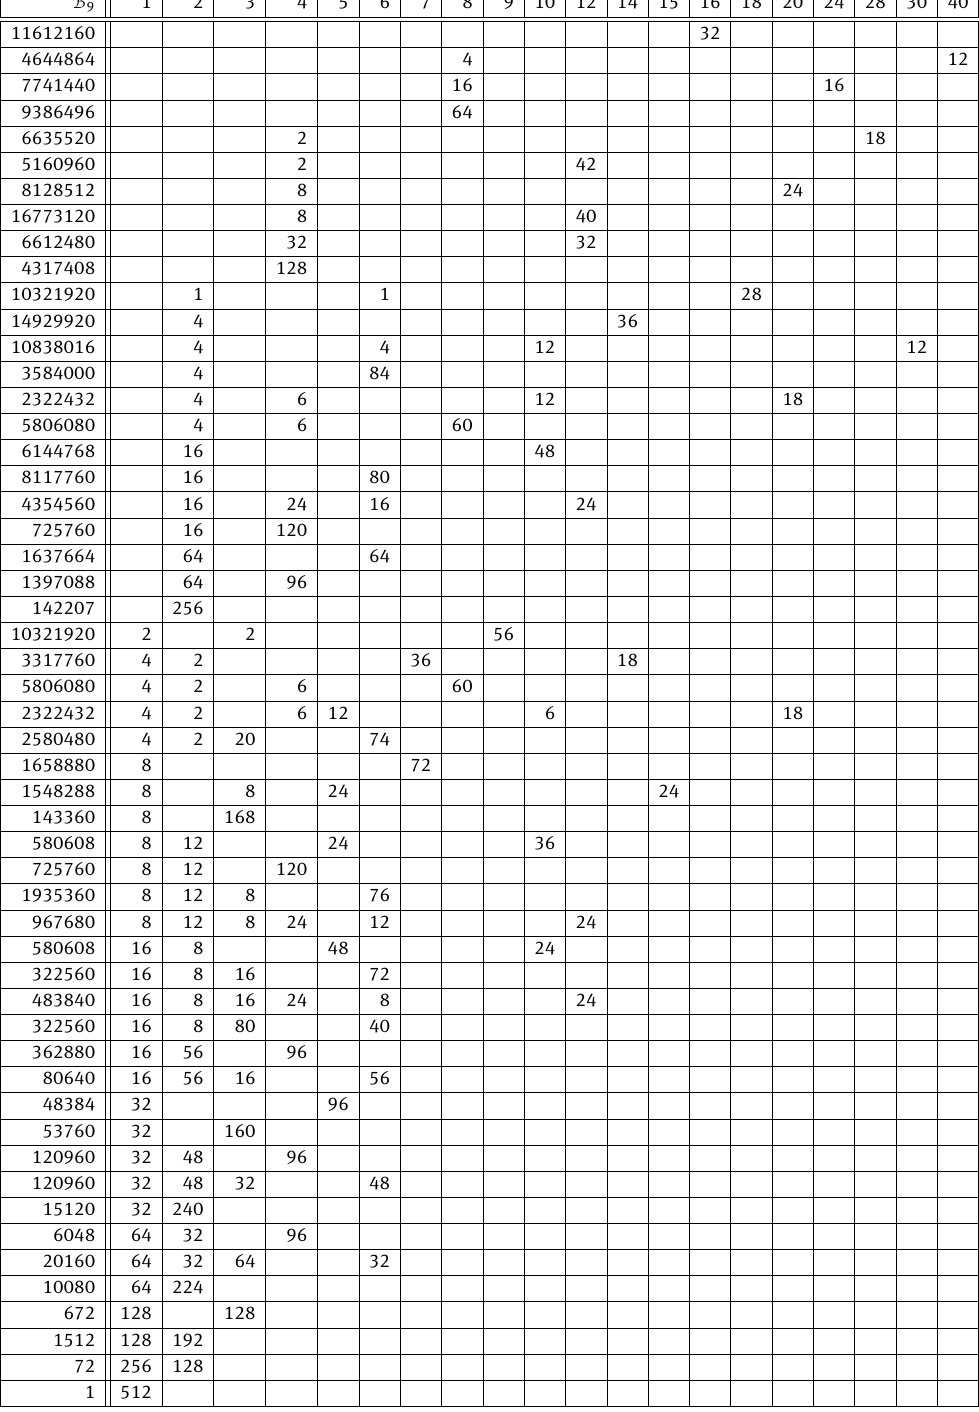
Table 12: The cycle index Z 9 in condensed tabulated